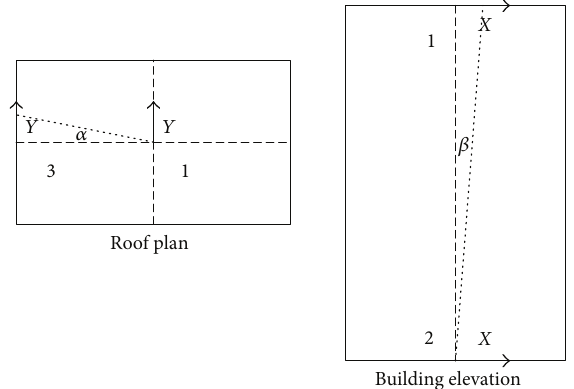
Figure 10: Torsional angle diagram view for the